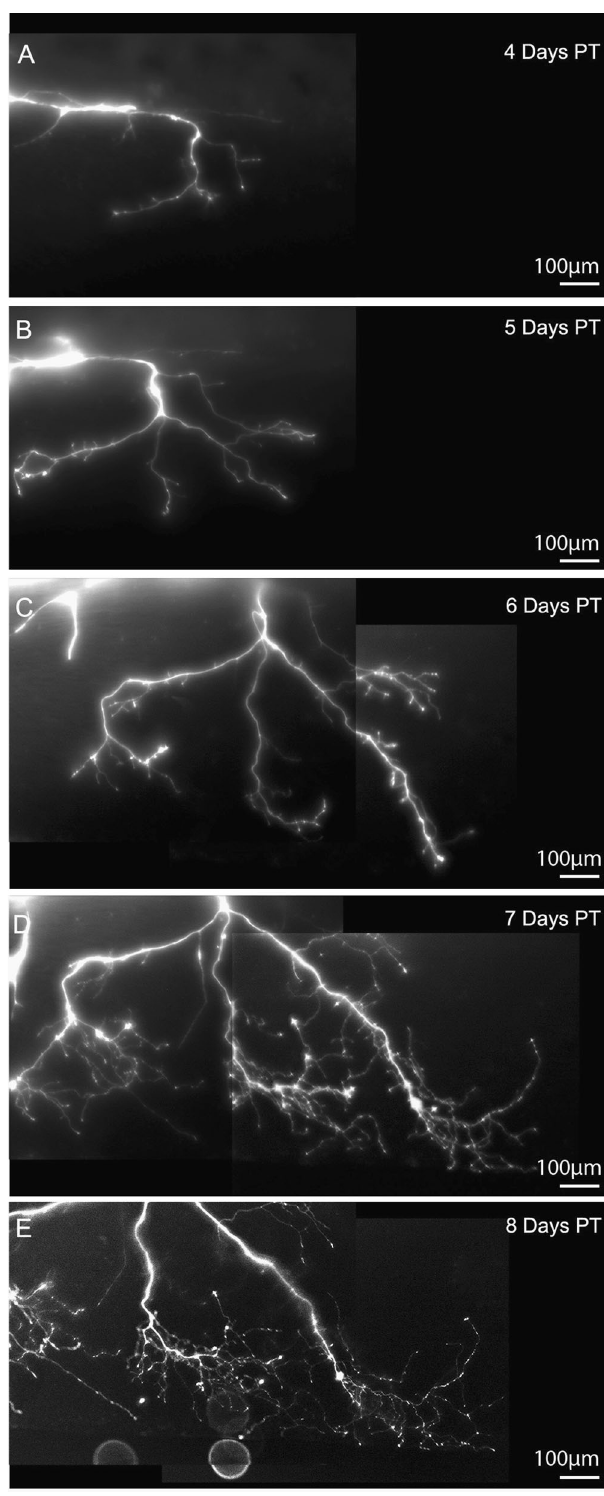
Fig. 3 Time-lapse imaging of 5-HT 1B/D -activated eye grafts reveals continued innervation and branching following treatment. a tdTomato labeled donor tissue was fi rst observed innervating the host 4 days post-transplant. By 5 and 6 days post-transplant ( b , c